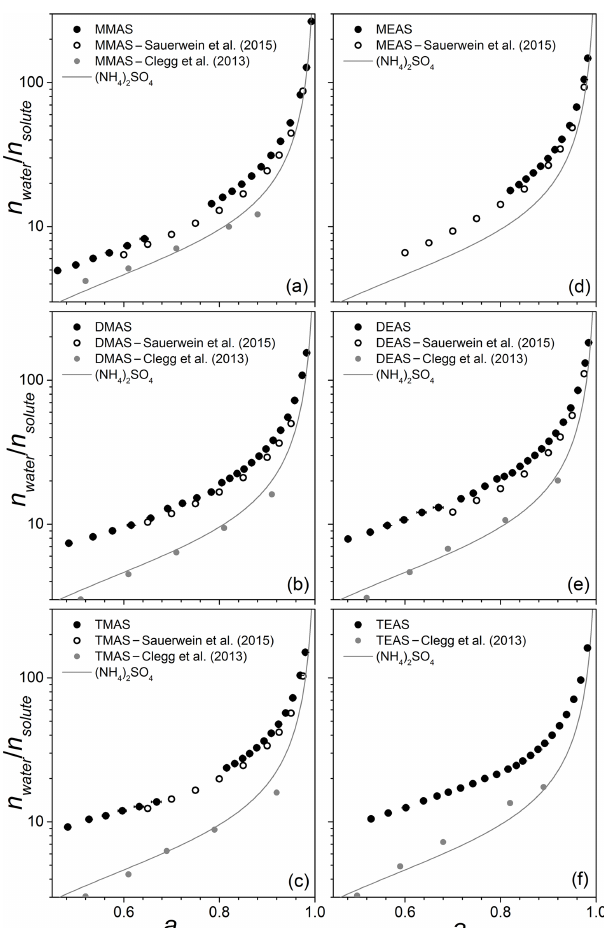
Figure 5. n water /n solute vs. a w plots for the six aminium sulfates. Symbols: black circles – CK-EDB comparative kinetics measure- ments; open circles – Sauerwein et al. (2015); grey dots – Clegg et al. (2013) (based on measurements from Qiu and Zhang, 2012); line – (NH 4 ) 2 SO 4 calculation from E-AIM